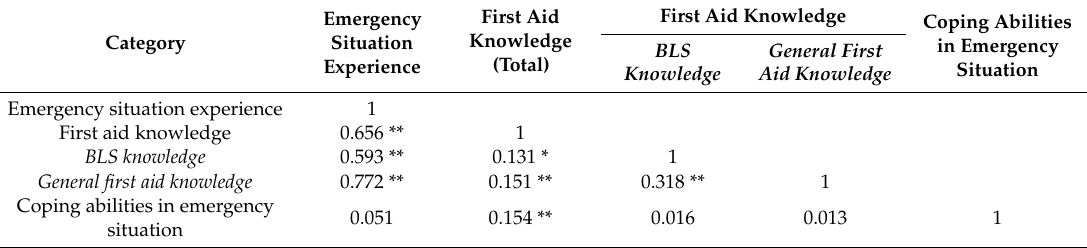
Table 3. Intercorrelation coe ffi cients among the measured variables ( N = 327).